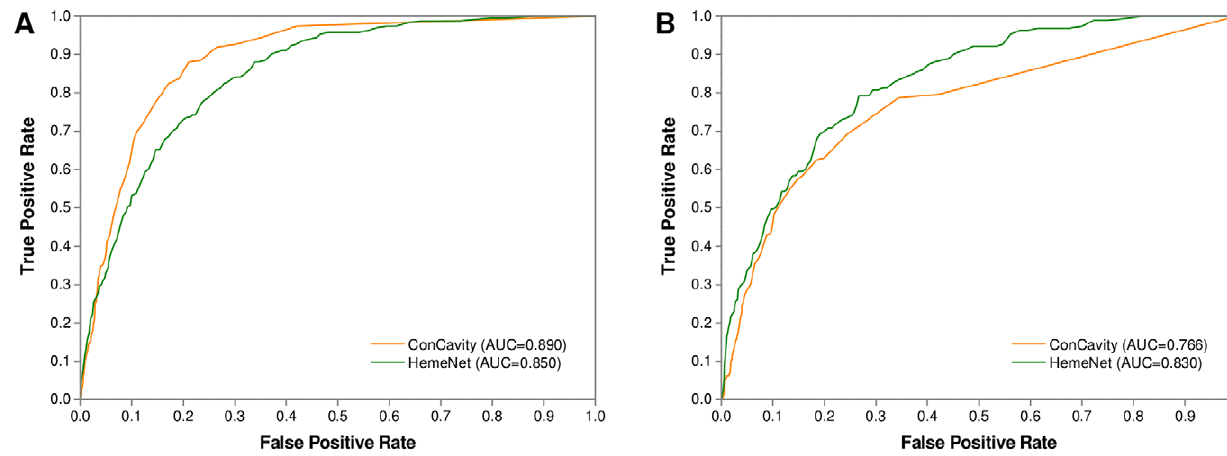
Figure 7. The ROC curves of ConCavity and HemeNet tested on holo-apo protein pairs. (a) Holo structures; (b) Apo structures.